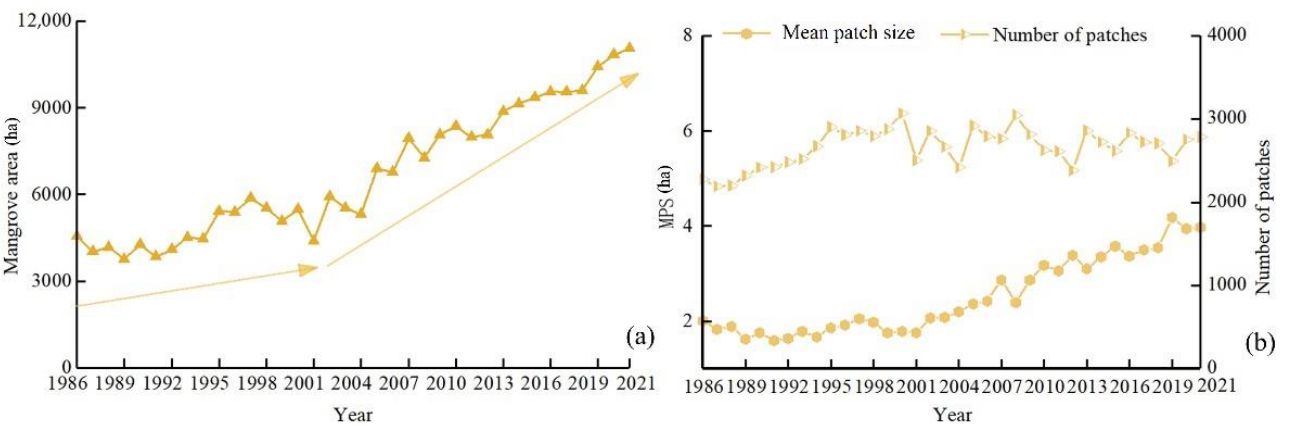
Figure 6. ( a ) Mangrove area and ( b ) the number of mangrove patches and MPS in Guangdong dur- ing 1986 – 2021.